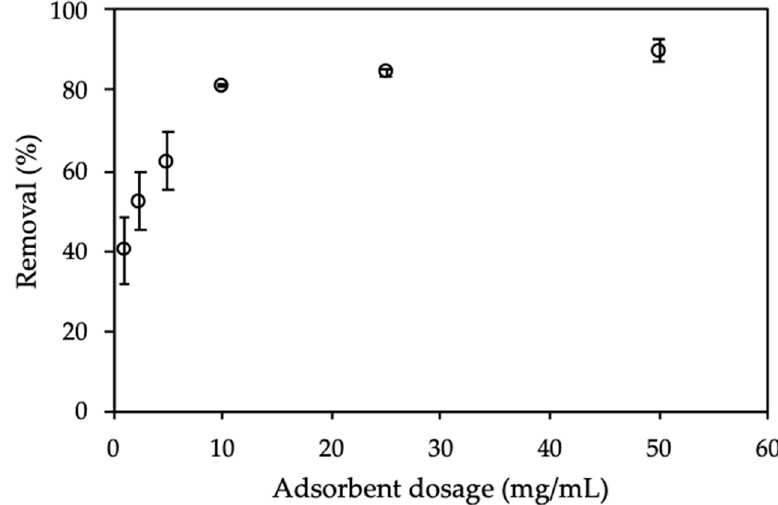
Figure 9. Effect of adsorbent dosage on removal of CFX using protein-modified nanosilica (ProMNS). C i (CFX) = 20 mg/L, pH 7.0, adsorption time 90 min, 1 mM KCl). Error bars show standard deviations of three replicates.